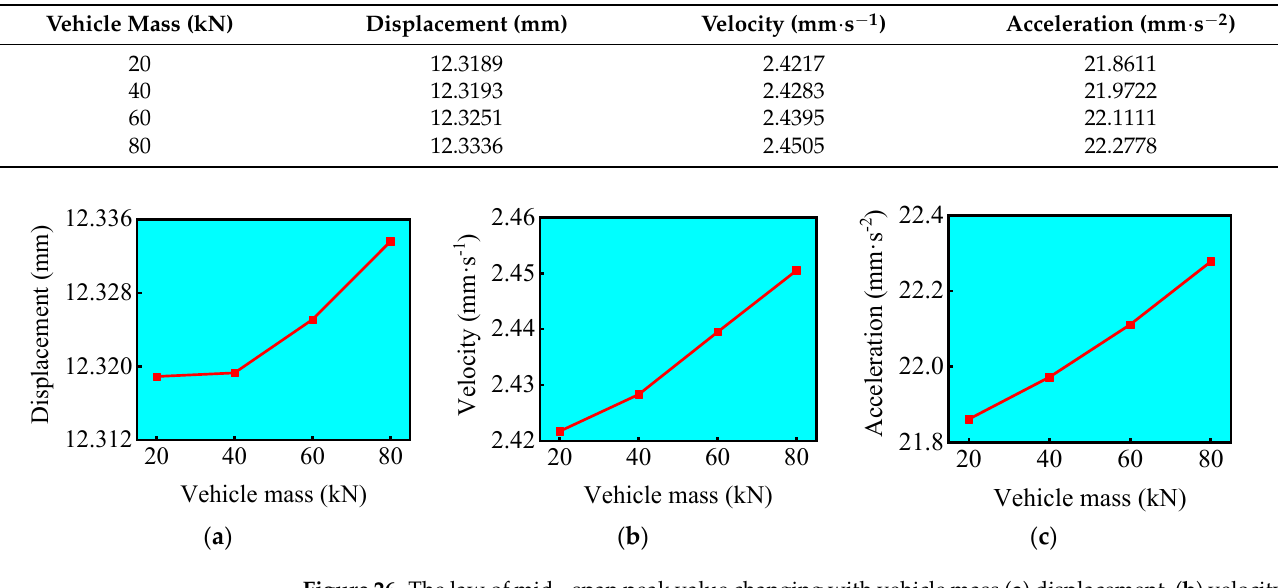
Figure 26. The law of mid − span peak value changing with vehicle mass ( a ) displacement, ( b ) velocity, and ( c )